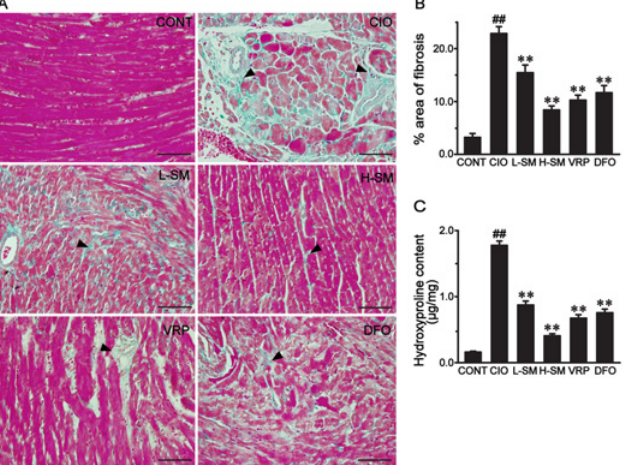
Fig 2. Effects of SM treatment on myocardial fibrosis. Representative micrographs were obtained from each group. The morphological location (A) and the percent area of myocardial fibrosis stained with Masson's trichrome staining (B) in each group are shown. The bright blue color represents the distribution of collagens (triangles), and the bar represents 50 μ m (original magnification, 400×). The myocardial Hyp content was calculated in each group (C). Values are means ± SEM. ## P < 0.01 vs. CONT group; ** P < 0.01 vs. CIO group.